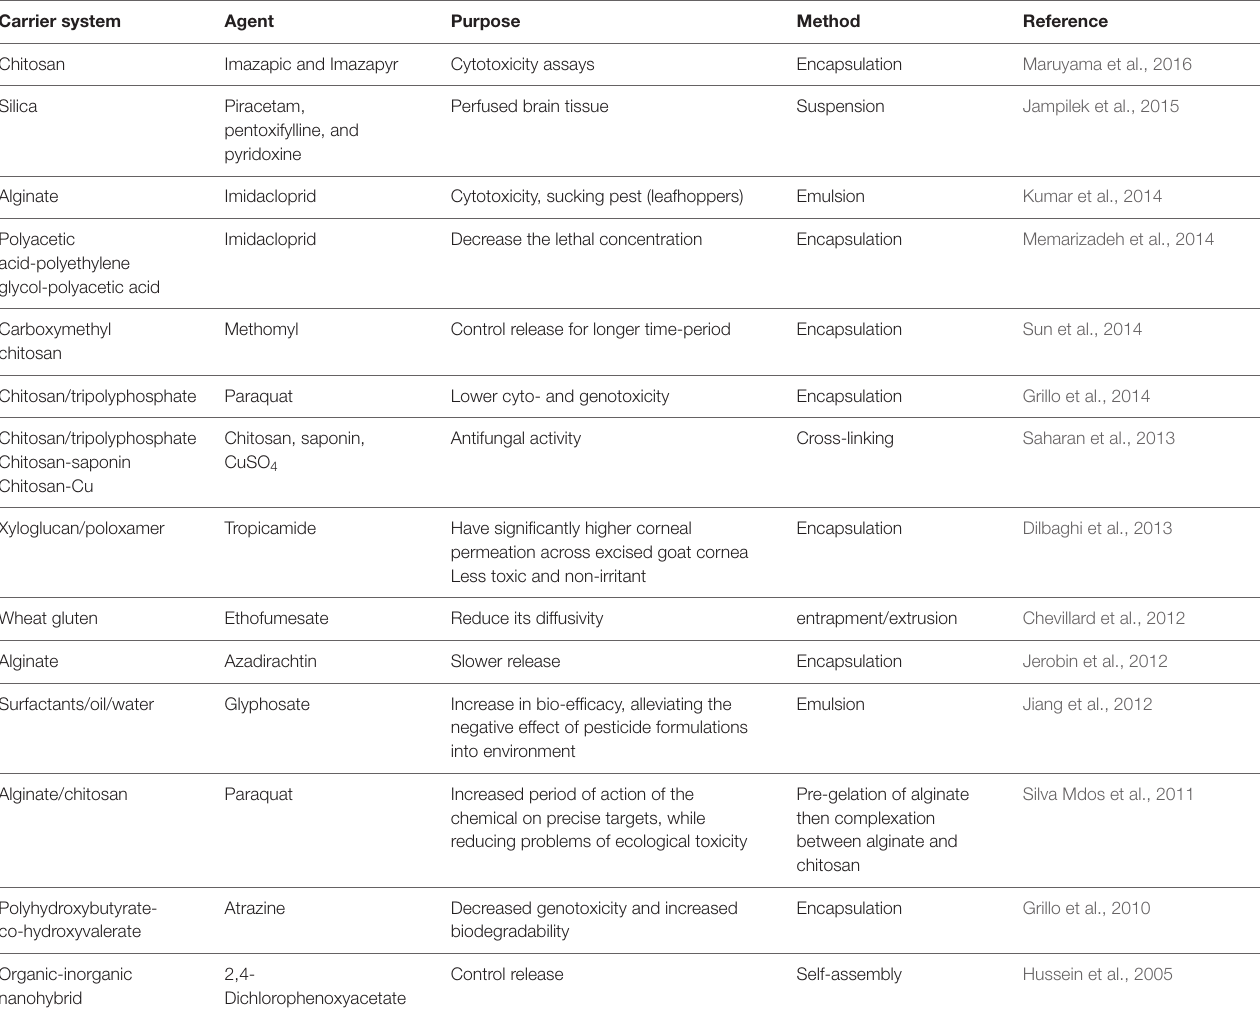
TABLE 2 | A list of studies on nanopesticides/herbicides and its